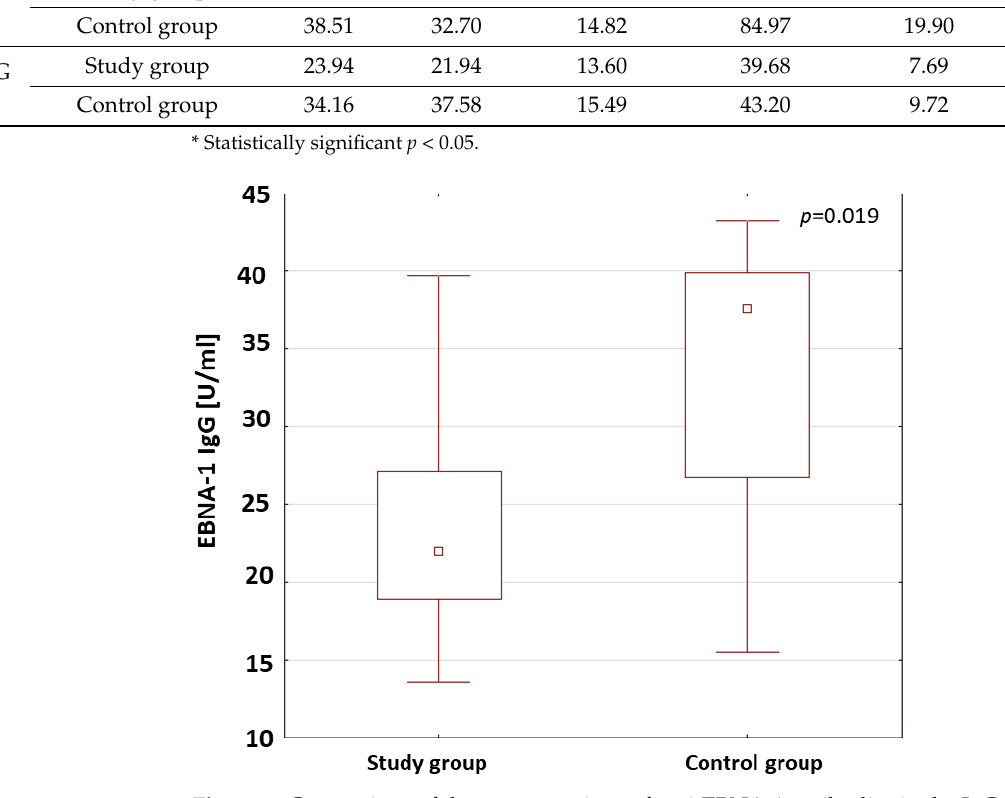
Figure 3. Comparison of the concentrations of anti-EBNA-1 antibodies in the IgG class in the study group and the control group.